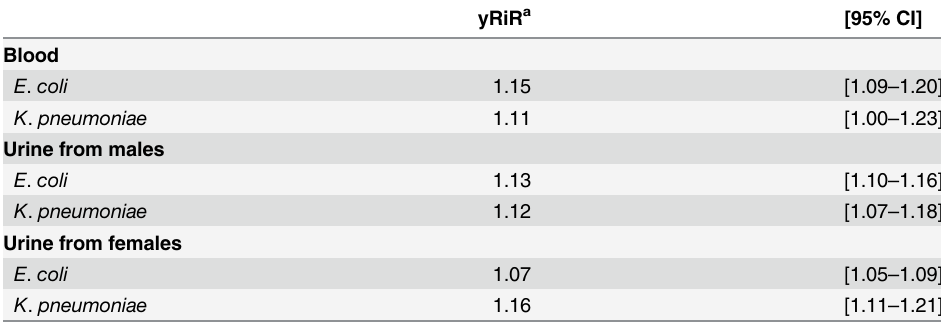
Table 2. Adjusted risk ratio ’ s (yRiR) per year for the time trends in proportion of Escherichia coli and Klebsiella pneumoniae isolates resistant to third generation cephalosporins, ISIS-AR, The Nether- lands, 2008 – 2012.